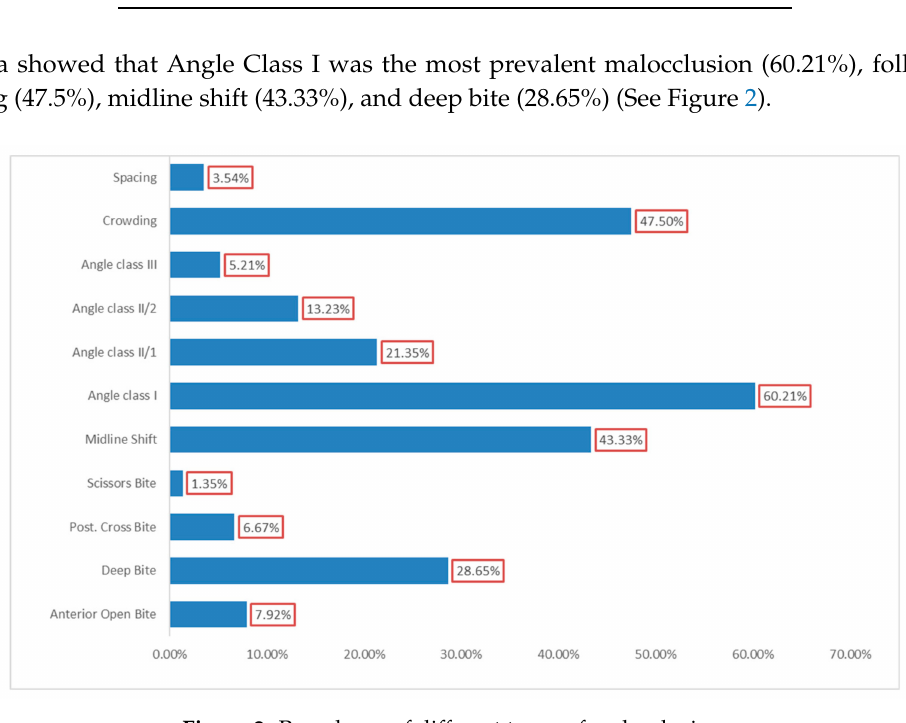
Figure 2. Prevalence of di ff erent types of